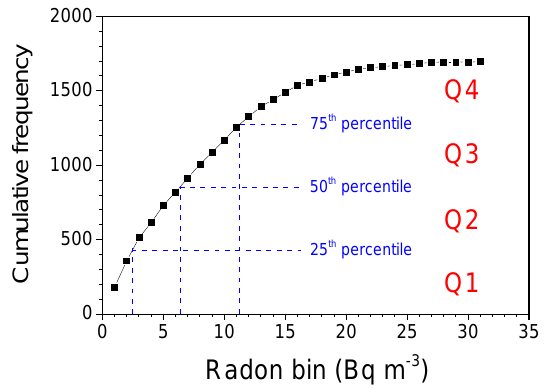
Figure 6. Cumulative frequency histogram of the daily mean pseudo-gradient in the 20:00–08:00EST window.